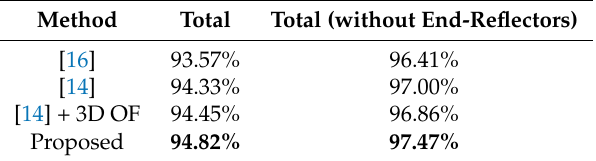
Table 5. mAP for PCK with α = 0.05, with and without end-reflectors, after filtering.